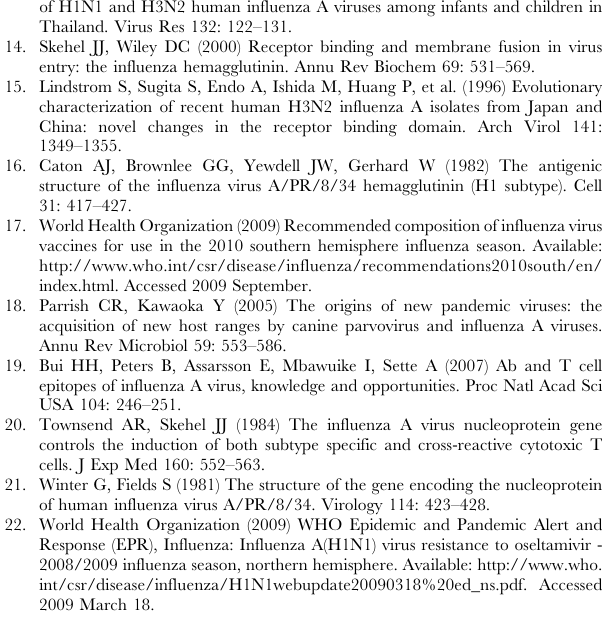
Table S2 Amino acid alterations in HLA epitope in internal protein. Alterative amino acids in red and brackets indicate the minor amino acid